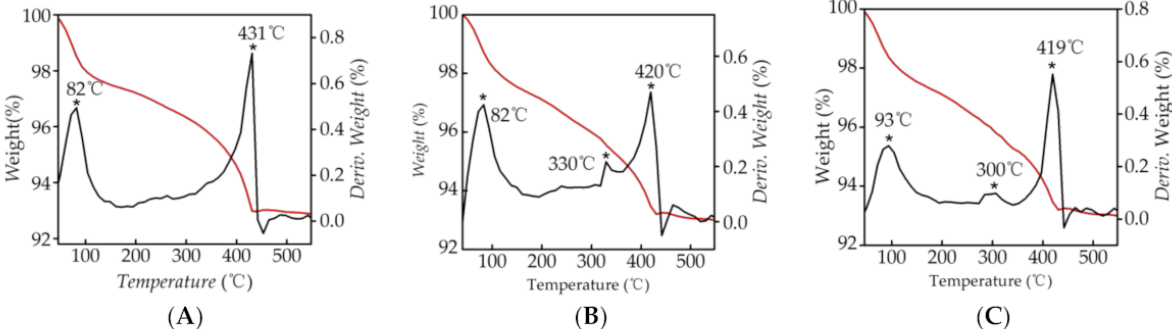
Figure 1. Thermostability of uncalcined samples: ( A ) K 0 CuCsNH 4 PAV; ( B ) K 0.6 CuCsNH 4 PAV; ( C ) K 1.2 CuCsNH 4